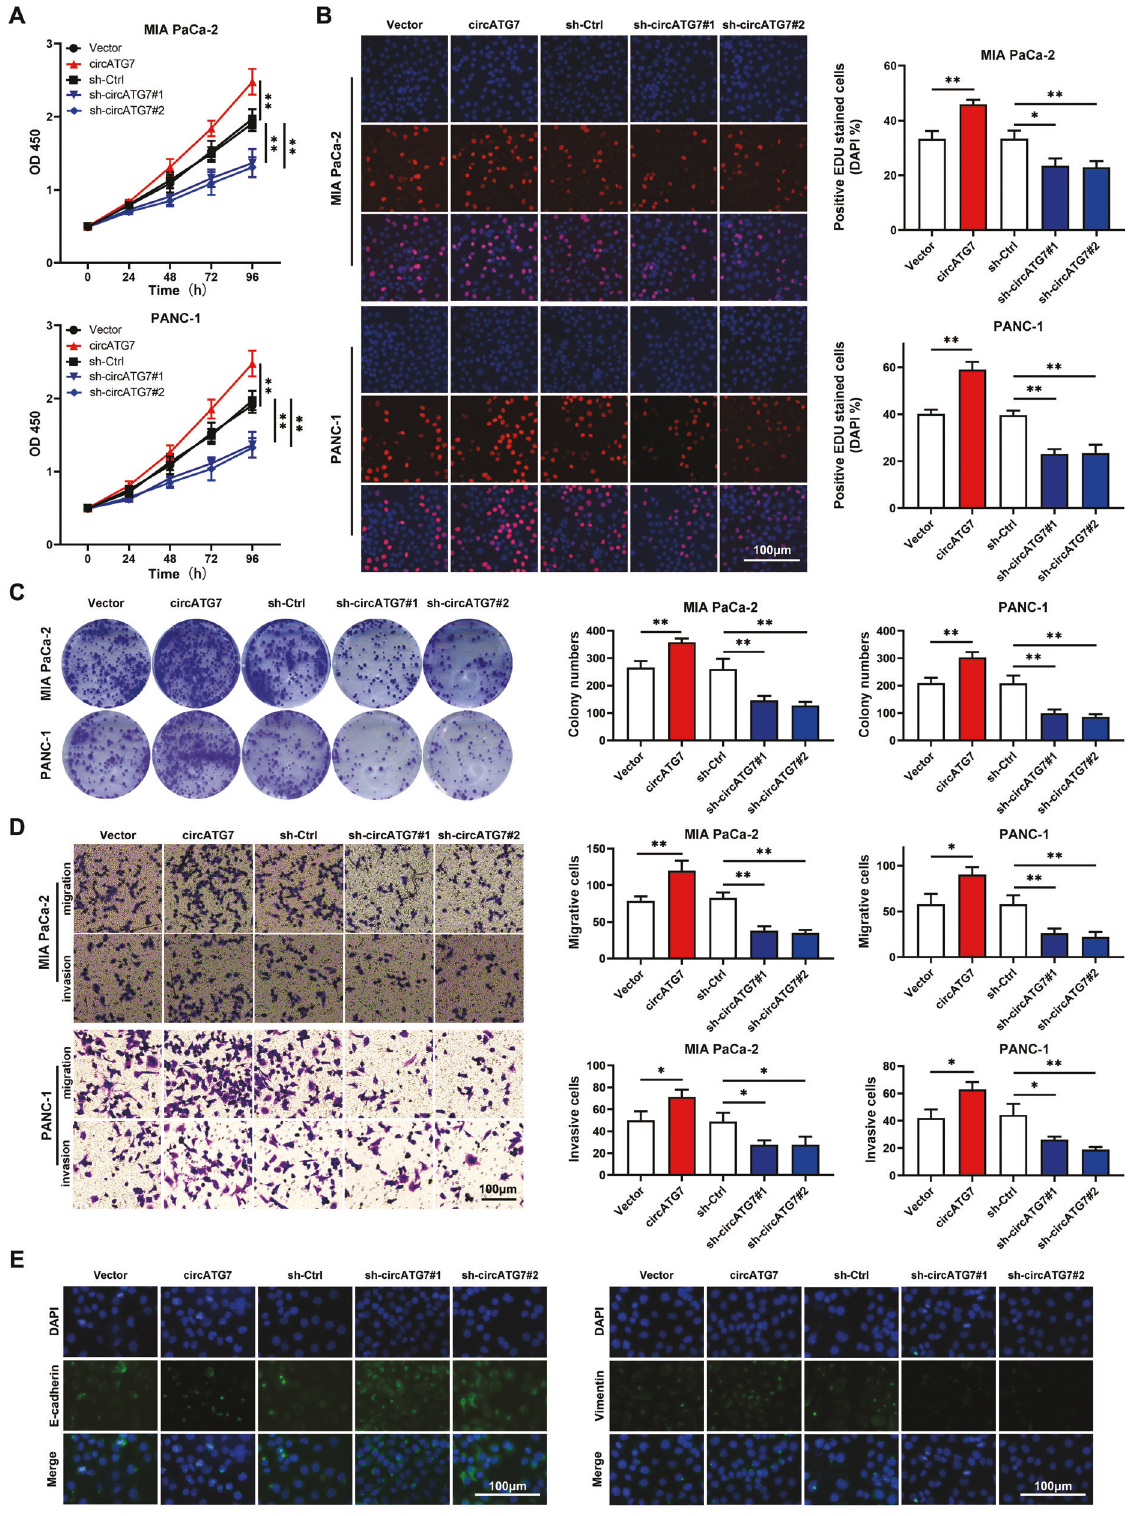
Fig. 3 CircATG7 promotes the proliferation and mobility of PC cells in vitro. A CCK-8 was used to determine the proliferation of PC cells with circATG7 gain or loss. B EDU assay was used to determine the EDU positivity of PC tissues with circ-ATG7-overexpressing or knockdown. C Colony formation assay was used to detect the number of colonies in circATG7-overexpressing, circATG7-knockdown, and negative control groups. D Migration and invasion Transwell assays were used to determine the migration and invasion of PC cells with circ-ATG7 overexpression or knockdown. E E-cadherin and vimentin expression in circ-ATG7-overexpressing and knockdown group PC cells were determined using immuno fl uorescence staining. * P < 0.05; ** P < 0.01.